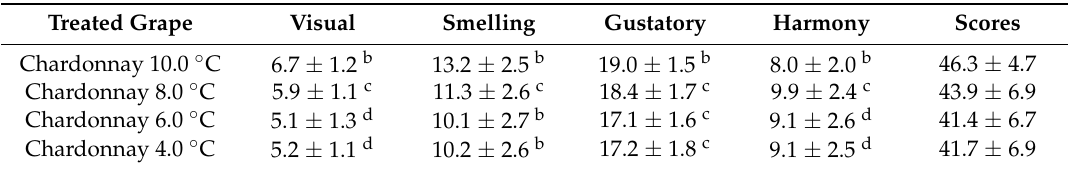
Table 5. Sensory analysis: scores range from 1 to 100, in which the value 100 corresponds to the lowest quality. Treated Grape Visual Smelling Gustatory Harmony Scores Chardonnay 10.0 ◦